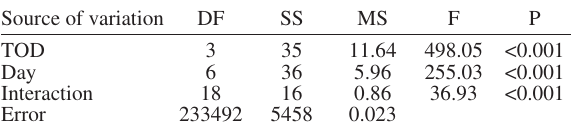
Table 2. – Results of a two-way analysis of variance comparing ves- sel effort by time of day and day of week off San Juan, Puerto Rico.